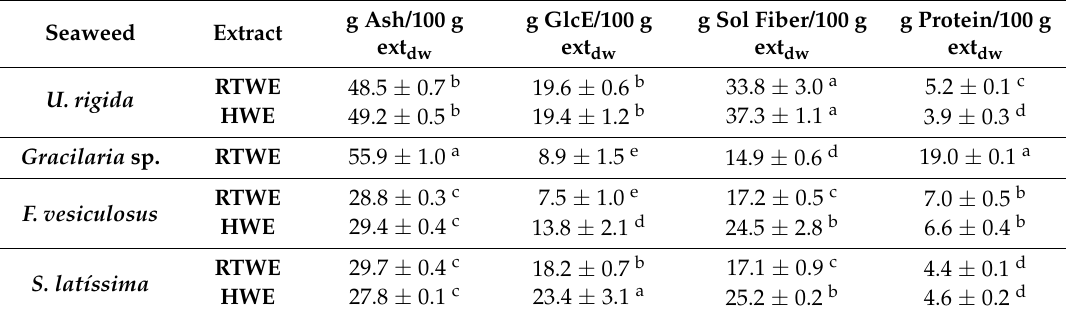
Table 5. Nutritional values of seaweed